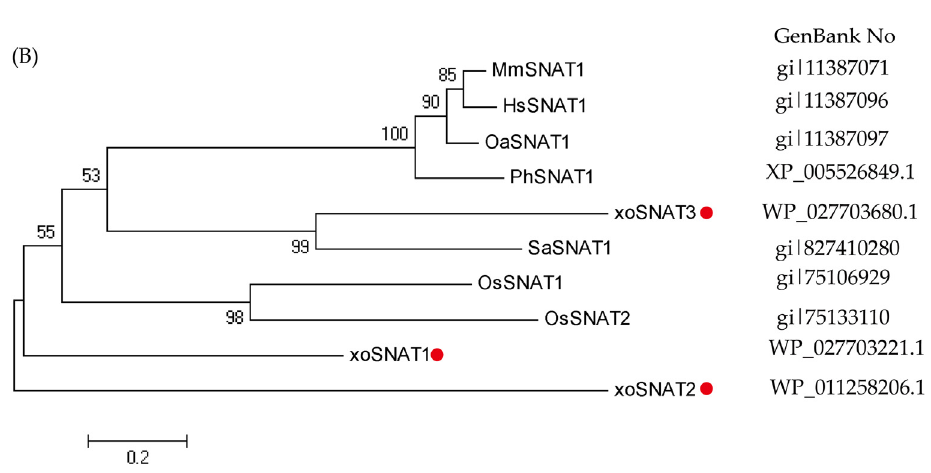
Figure 3. Phylogenetic tree of MT biosynthetic gene xoSNAT3. ( A ) Amino acid sequence alignment of xoSNAT3 and 9 GNAT family members. ( B ) Phylogenetic tree of xoSNAT3 and nine GNAT family members. The phylogenetic tree was constructed using MEGA-6, based on the amino acid sequences of SNATs from Xoo and some representative organisms. Phylogenetic analysis was performed by using Neighbor likelihood algorithm. The parameters were: Test of Phylogeny-“Bootstrap method,” No of Bootstrap replications-“1000,” Substitutions type-“Amino acid,” Rates among sites-“Uniform rates,” Pattern among Lineages-“Same (Homogeneous),” and Gaps/Missing Data Treatment-“Complete deletion”.